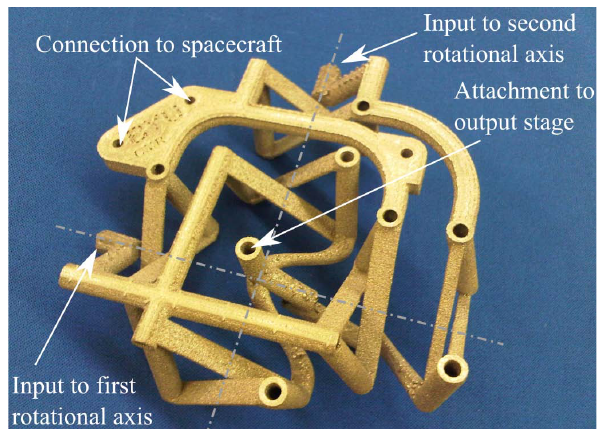
Figure 1a. Annotated photograph of a 3-D printed titanium 2 DOF pointing mechanism.